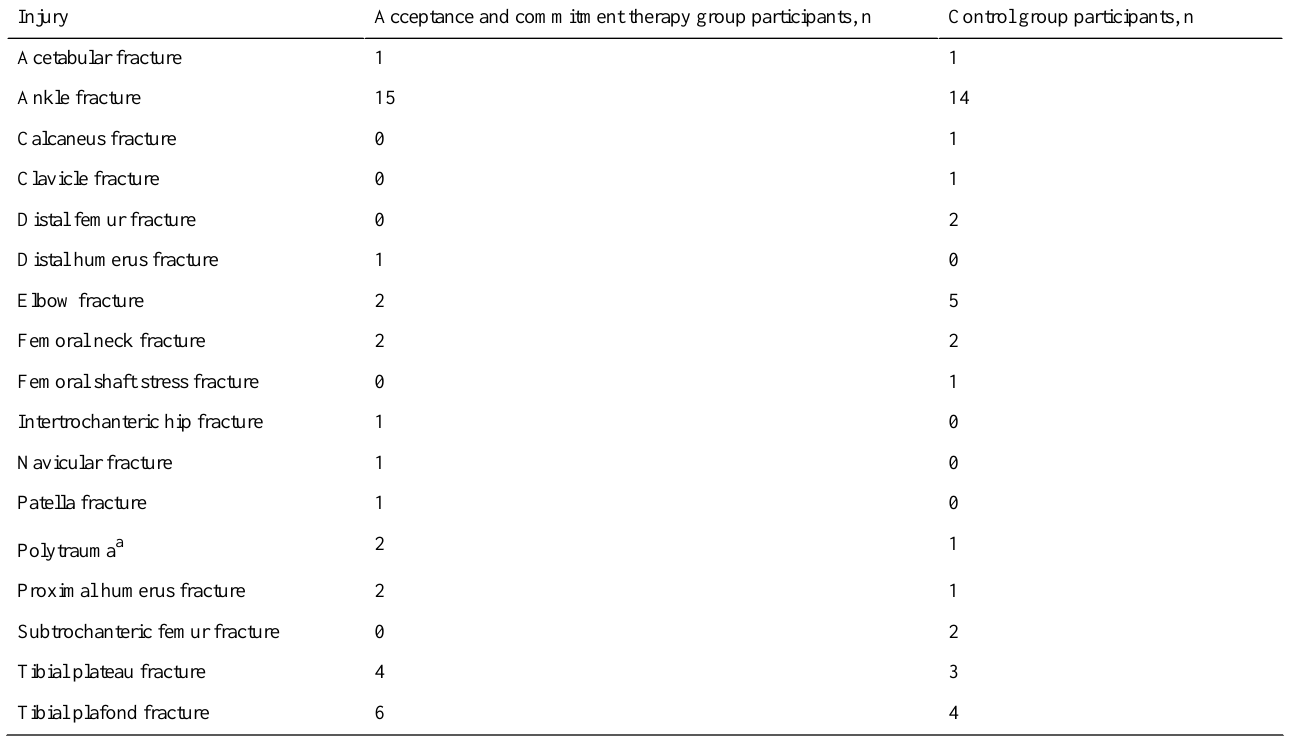
Table 2. Injury by final study group